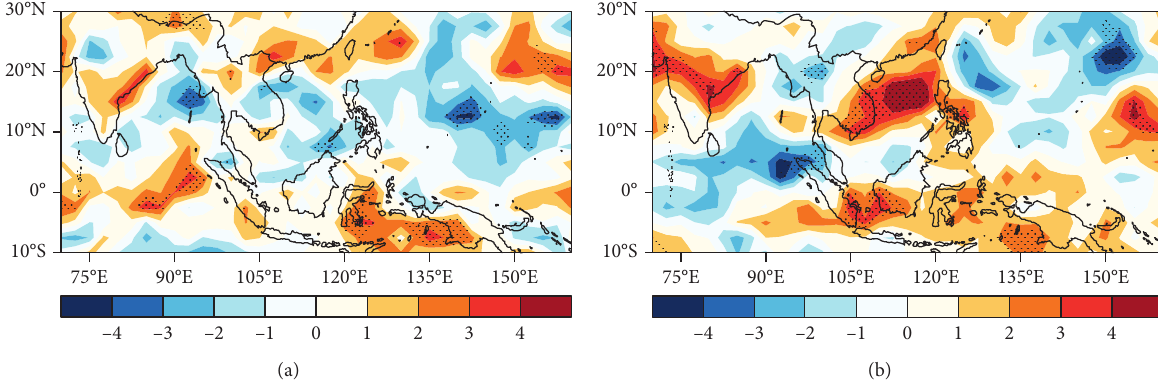
Figure 10: Difference in the Lanczos filtered OLR anomalies in (a) 10–25-day and (b) 30–80-day time scales from 15 May to 15 October between 1994–2016 and 1979–1993. Units are in W/m 2 , and the dotted areas denote that the differences are significant at the 95% confidence level.